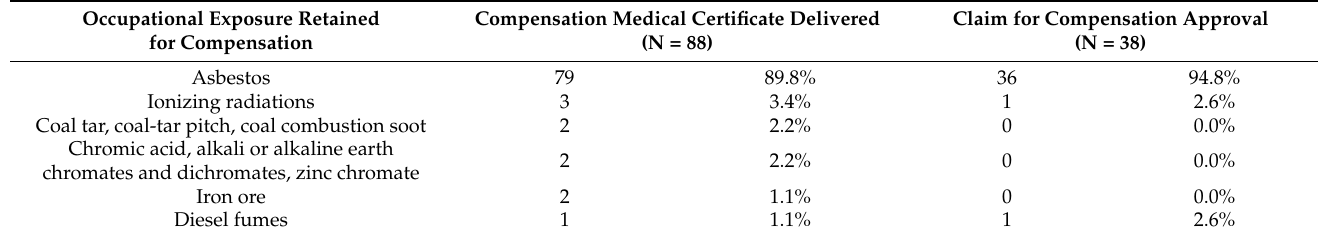
Table 5. Main occupational exposure retained (number and proportion) by the physician and claim for compensation outcome, 2017–2019,